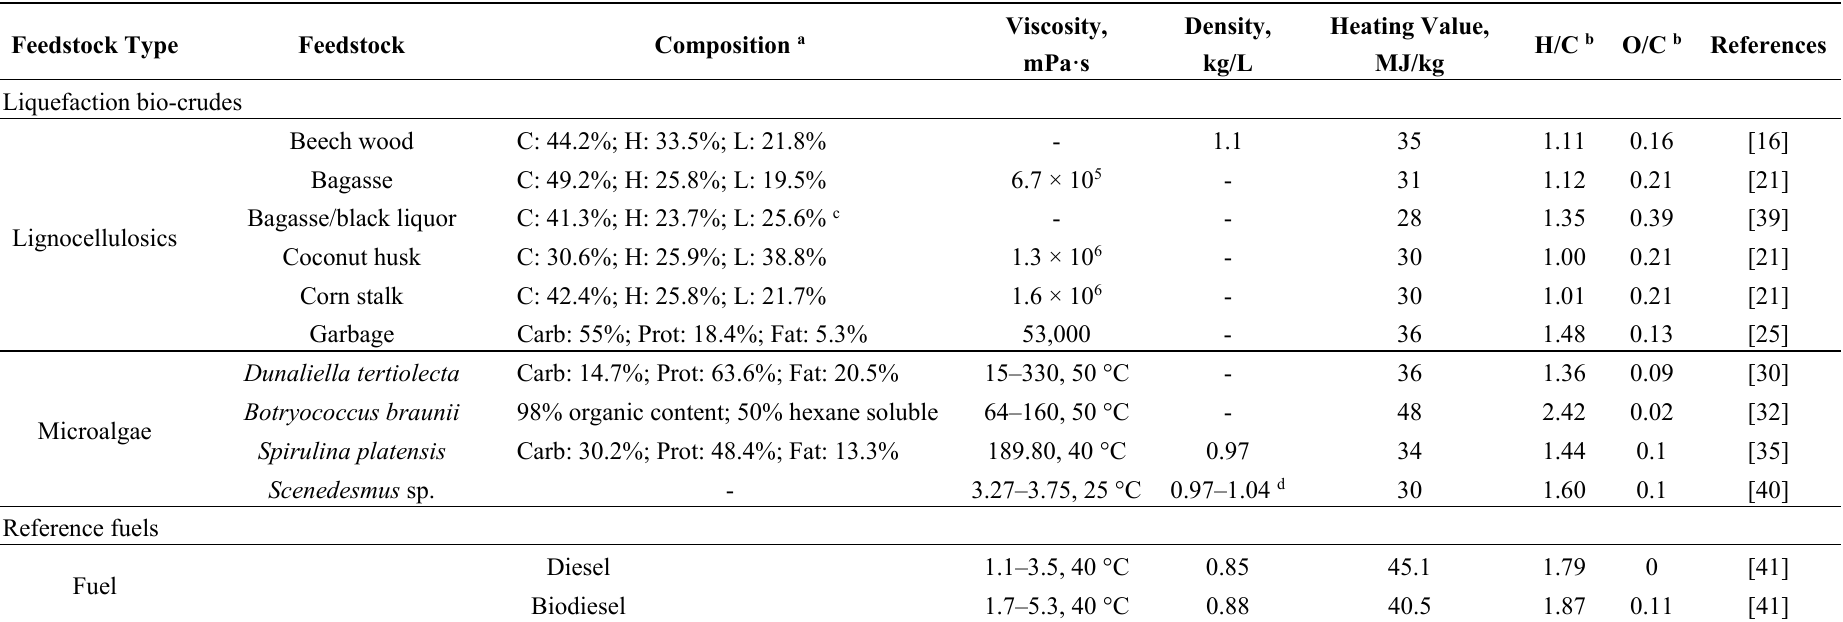
Table 1. Bio-crude produced from various feedstock and their